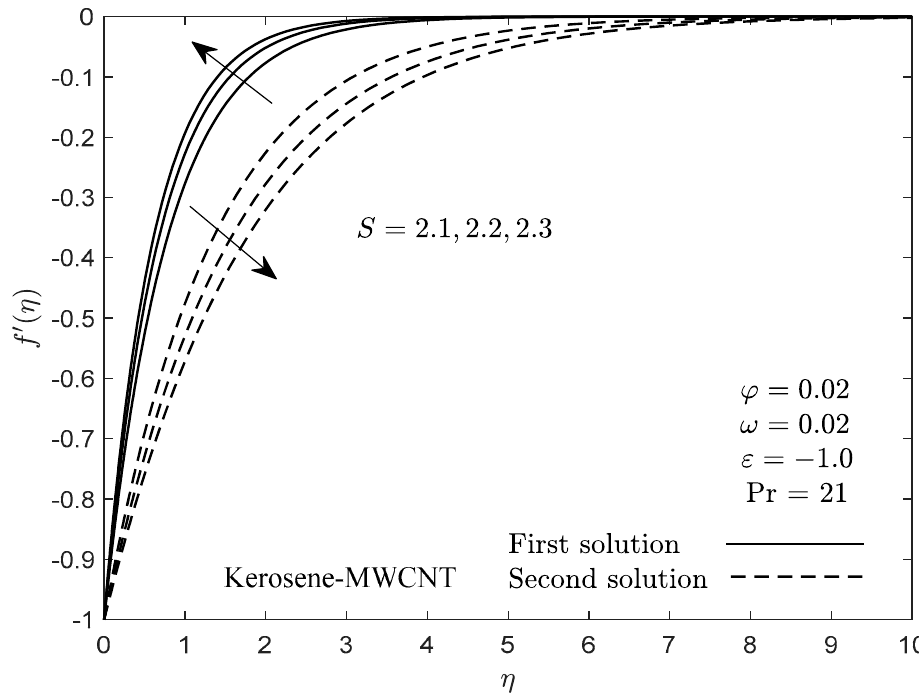
Figure 12. Velocity profiles of 𝑥 -component 𝑓 (cid:4593) (𝜂) for some values of 𝑆 .